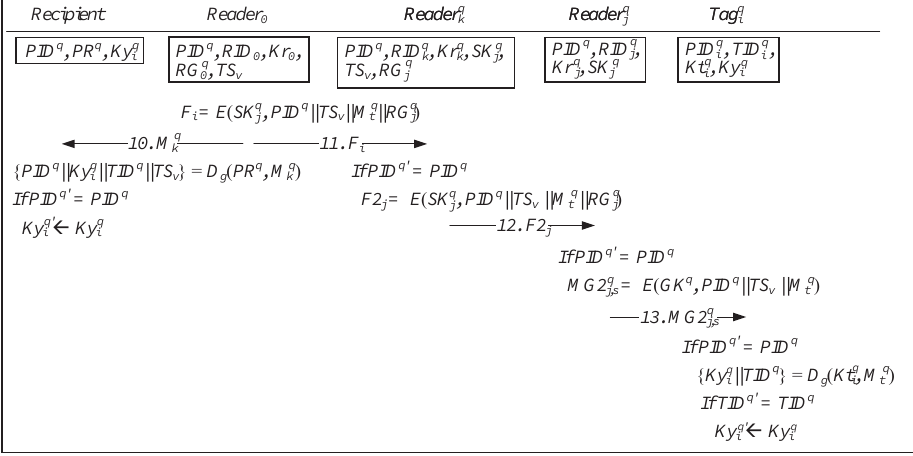
Figure 6. Updating ownership by shared